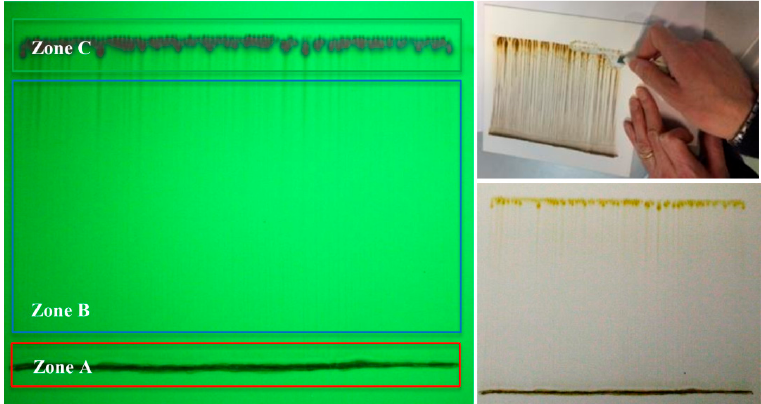
Figure 3. Separated spots on silica gel plate (160/220 Industrial bitumen sample). Three distinguished